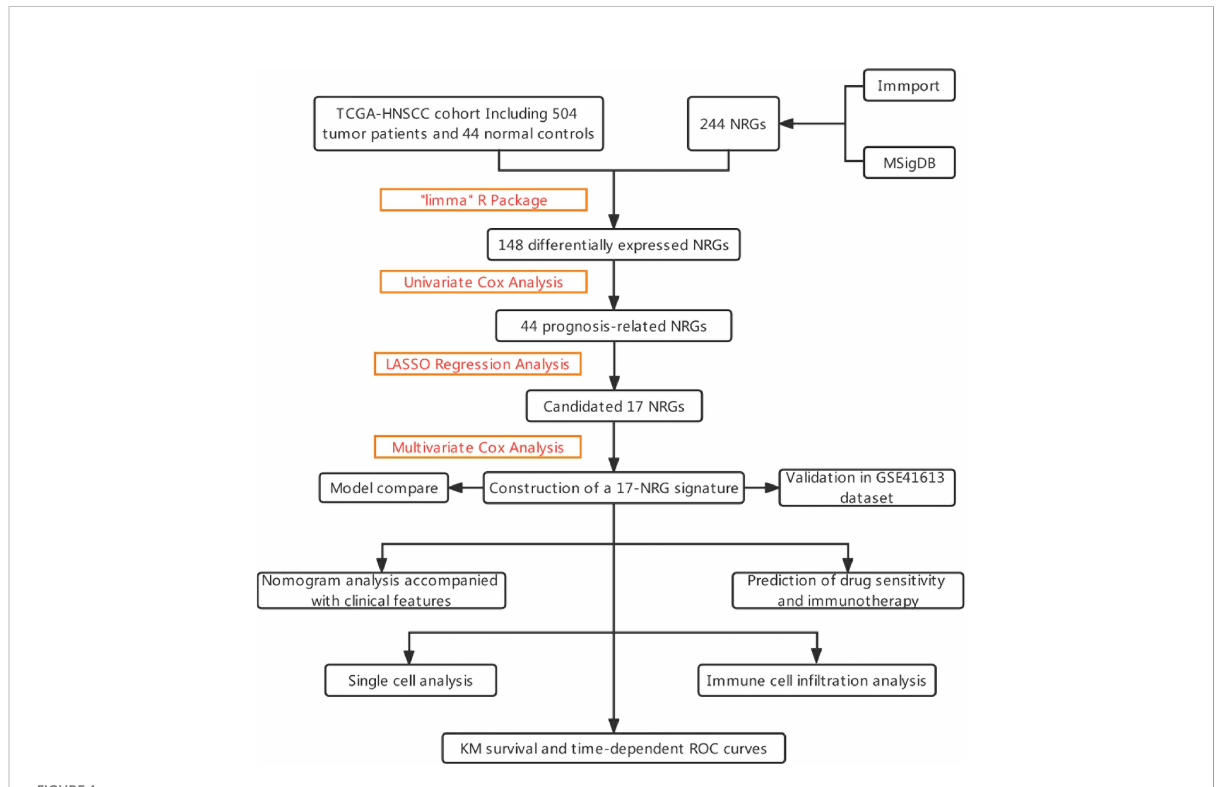
FIGURE 1 The fl owchart summarizes the main design of the present